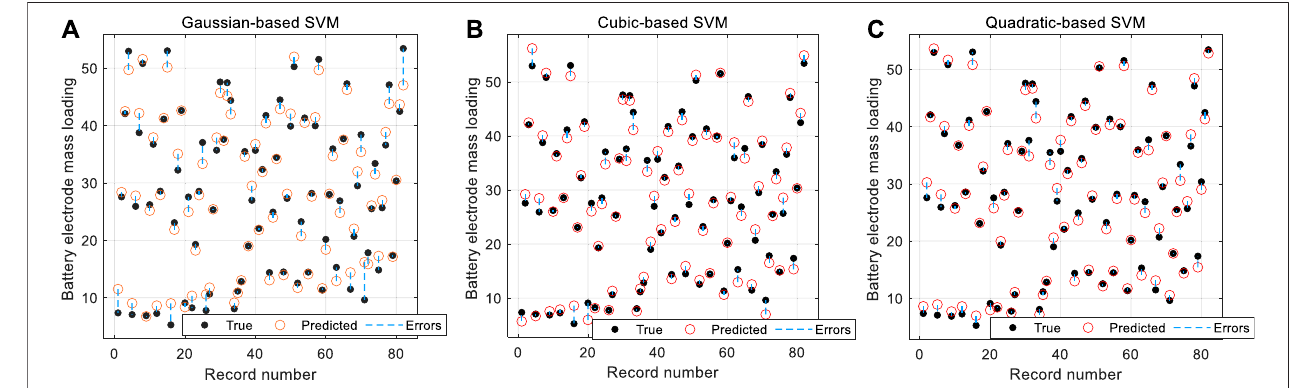
FIGURE 3 | Prediction results for battery electrode mass loading using different kernel-based SVMs.